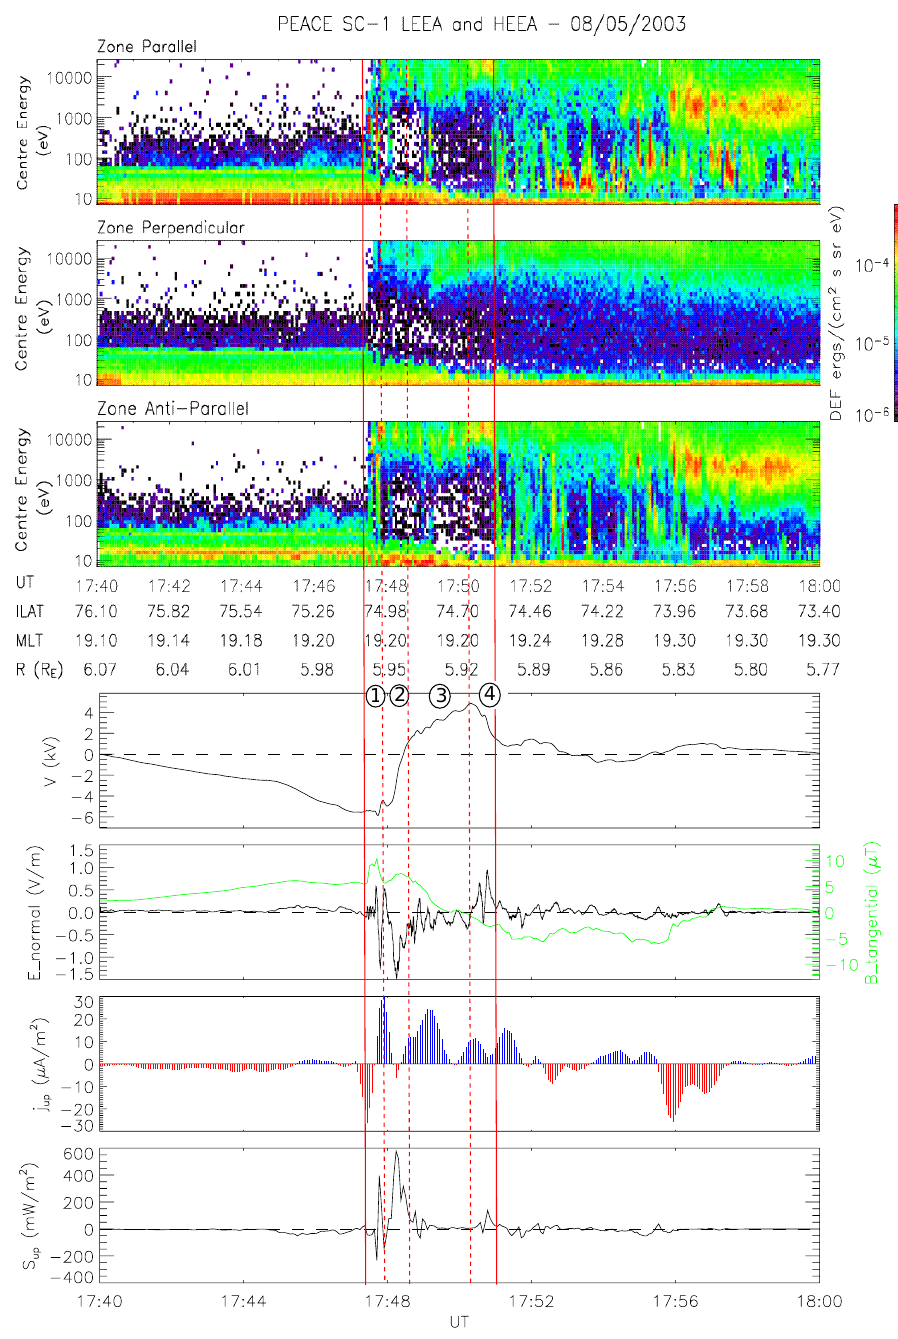
Fig. 2. Data from Cluster spacecraft 1 for the time interval 17:40 and 18:00UT on 8 May 2003. Panels 1 to 3 – Electron energy flux spectrogram versus energy and time at pitch angles 0, 90 and 180 ◦ , respectively. Pitch angle of 0 ◦ corresponds to upgoing and 180 ◦ to downgoing electrons on the Southern Hemisphere. Panel 4 – Calculated perpendicular potential. Panel 5 – Normal component of the electric field (black line); Tangential component of the magnetic field (green line). Panel 6 – Field-aligned current density distribution, with blue color showing upflowing currents and red color downflowing currents. Panel 7 – Field-aligned component of the Poynting flux vector, with positive values indicating upward field-aligned flux. All quantities are mapped to the